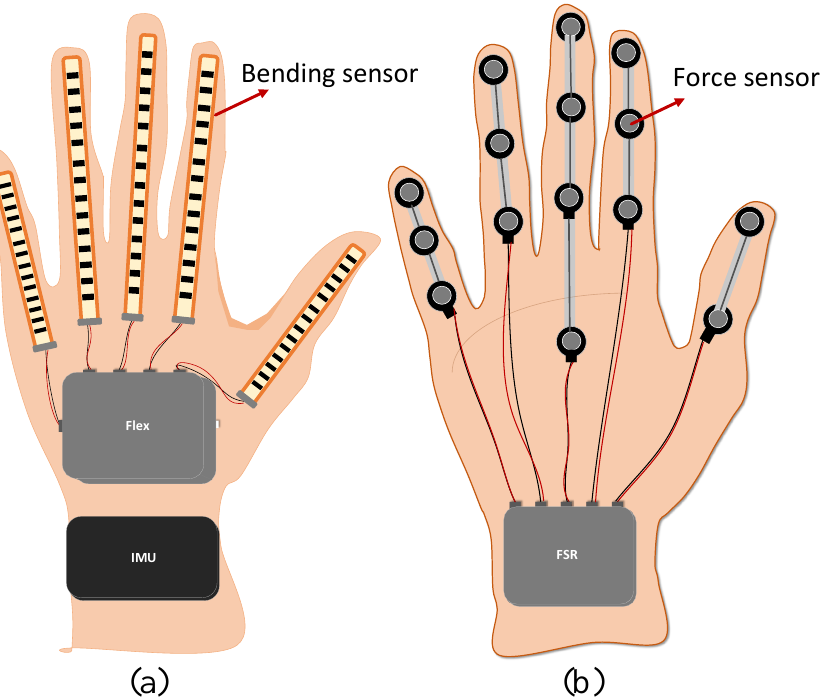
Figure 4. The tactile glove and sensor distribution. ( a ) Distribution of bending sensors and IMU on the back of hand. ( b ) Distribution of pressure sensors in palm.